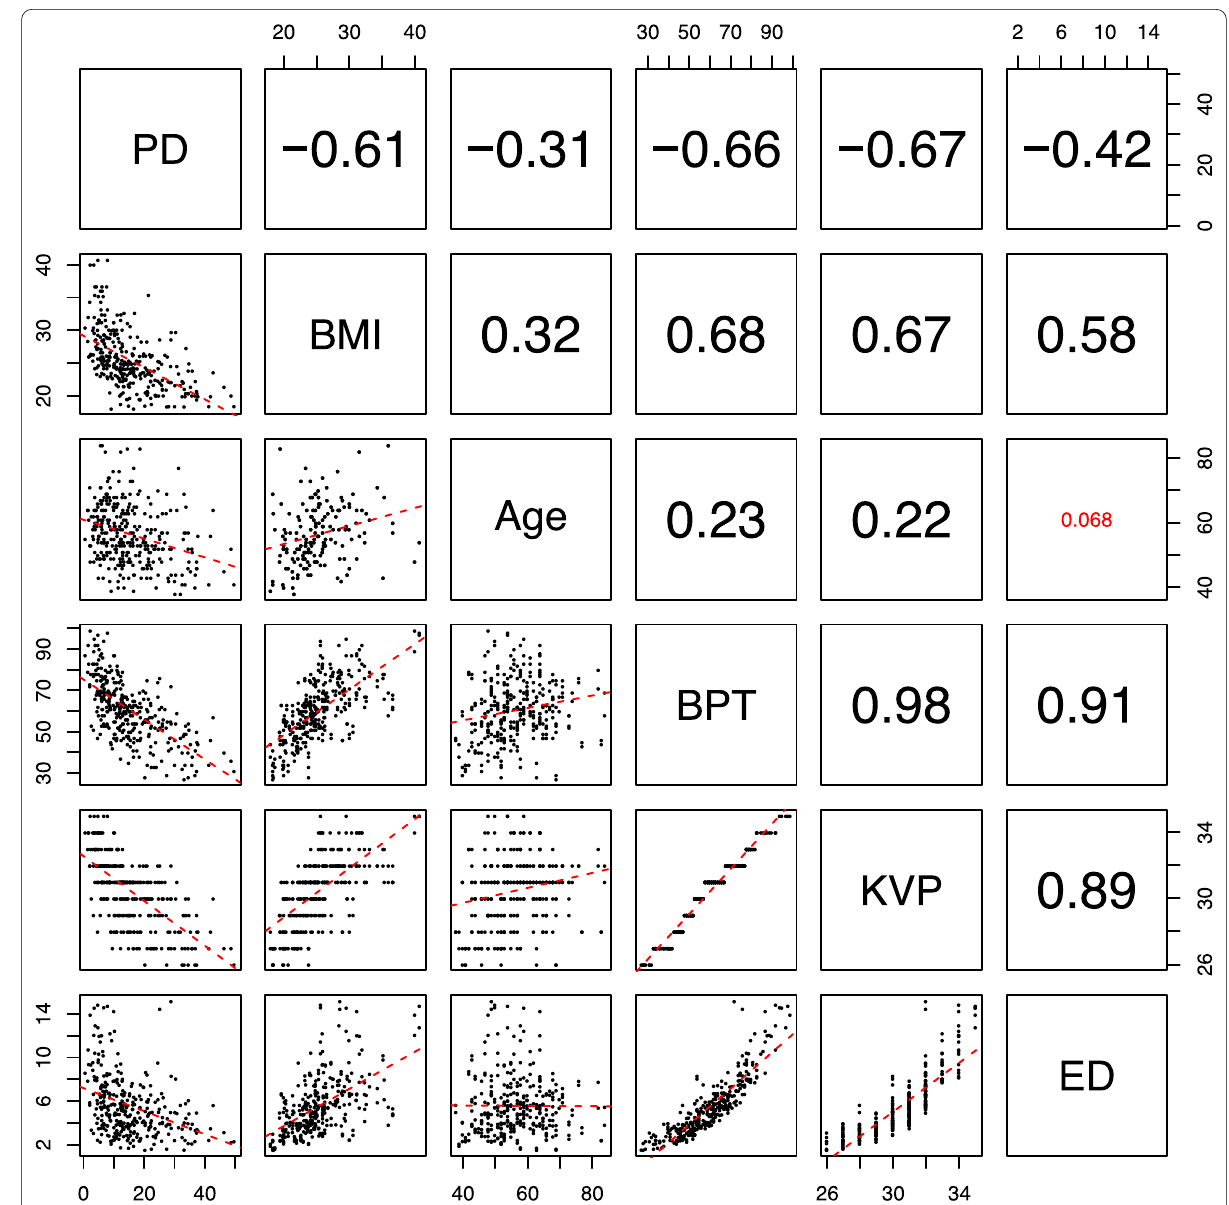
Fig. 6 Correlations among equipment variables and patient features: per each couple of variables, scatter plot and spearman correlation value have been reported. Lower matrix: scatter plot; Upper matrix: correlation with Spearman Correlation Coefficient.The Spearman correlation coefficient, rs, can take values from 1 to 1. A rs of 1 indicates a perfect association of ranks, a rs of zero indicates no association between ranks and a rs of + − + indicates a perfect negative association of ranks. The closer rs is to zero, the weaker the association between the ranks. PD percent density (%), BMI; BPT body part thickness (mm), KVP kVp; ED entrance dose (mGy). In small font (red in color version) not significant correlations ( p >